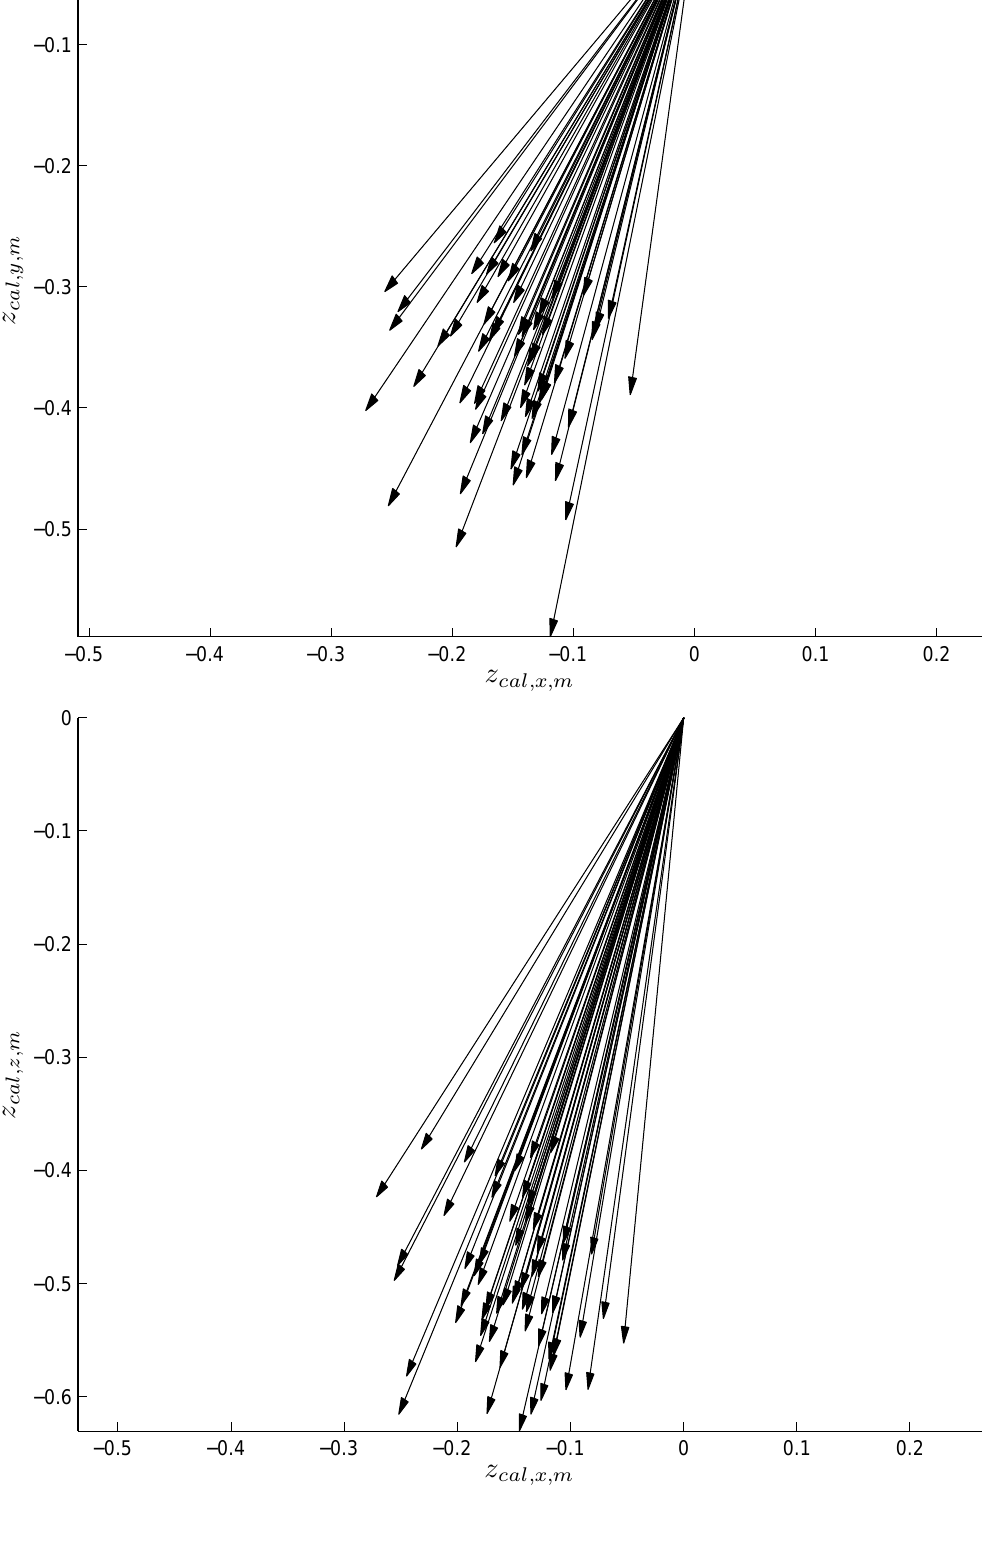
Figure 9. Vector plot of z